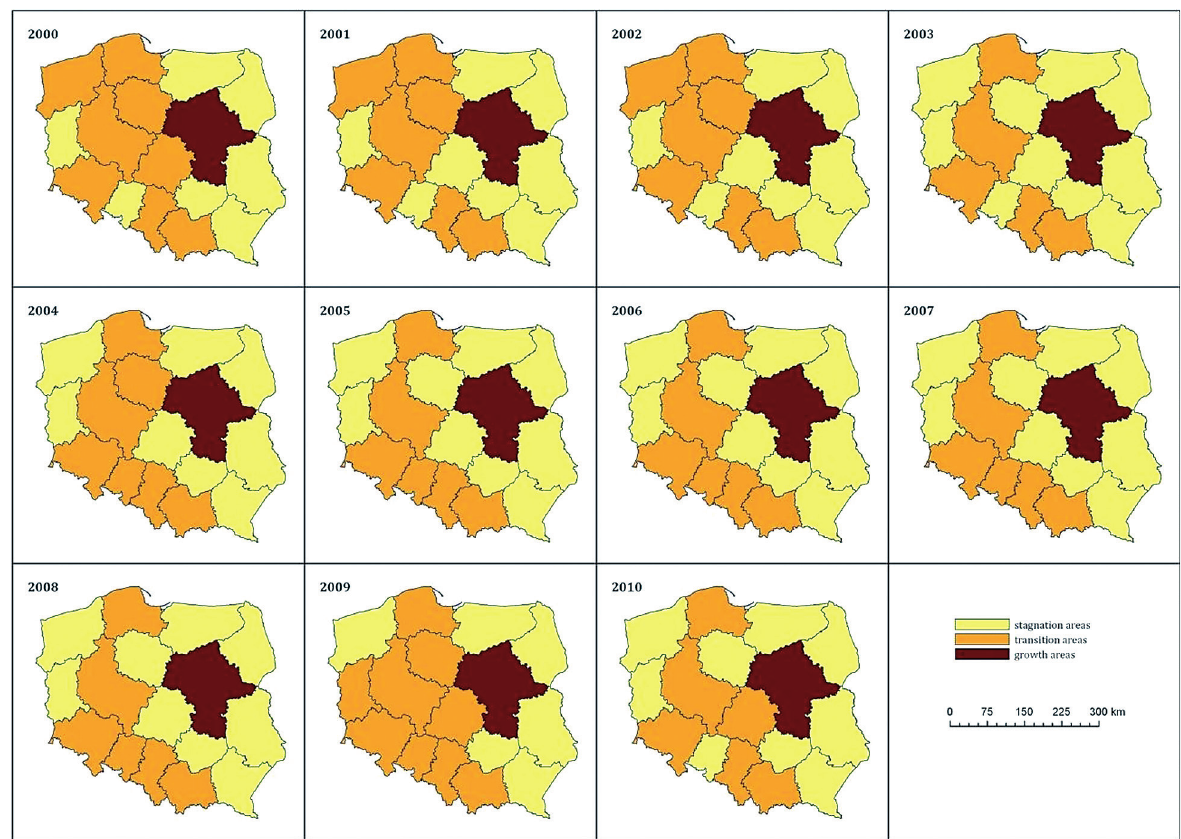
Fig. 1. Distribution of areas of economic growth and stagnation at the regional (NUTS 2) level in the years 2000–2010: a general approach Source: own